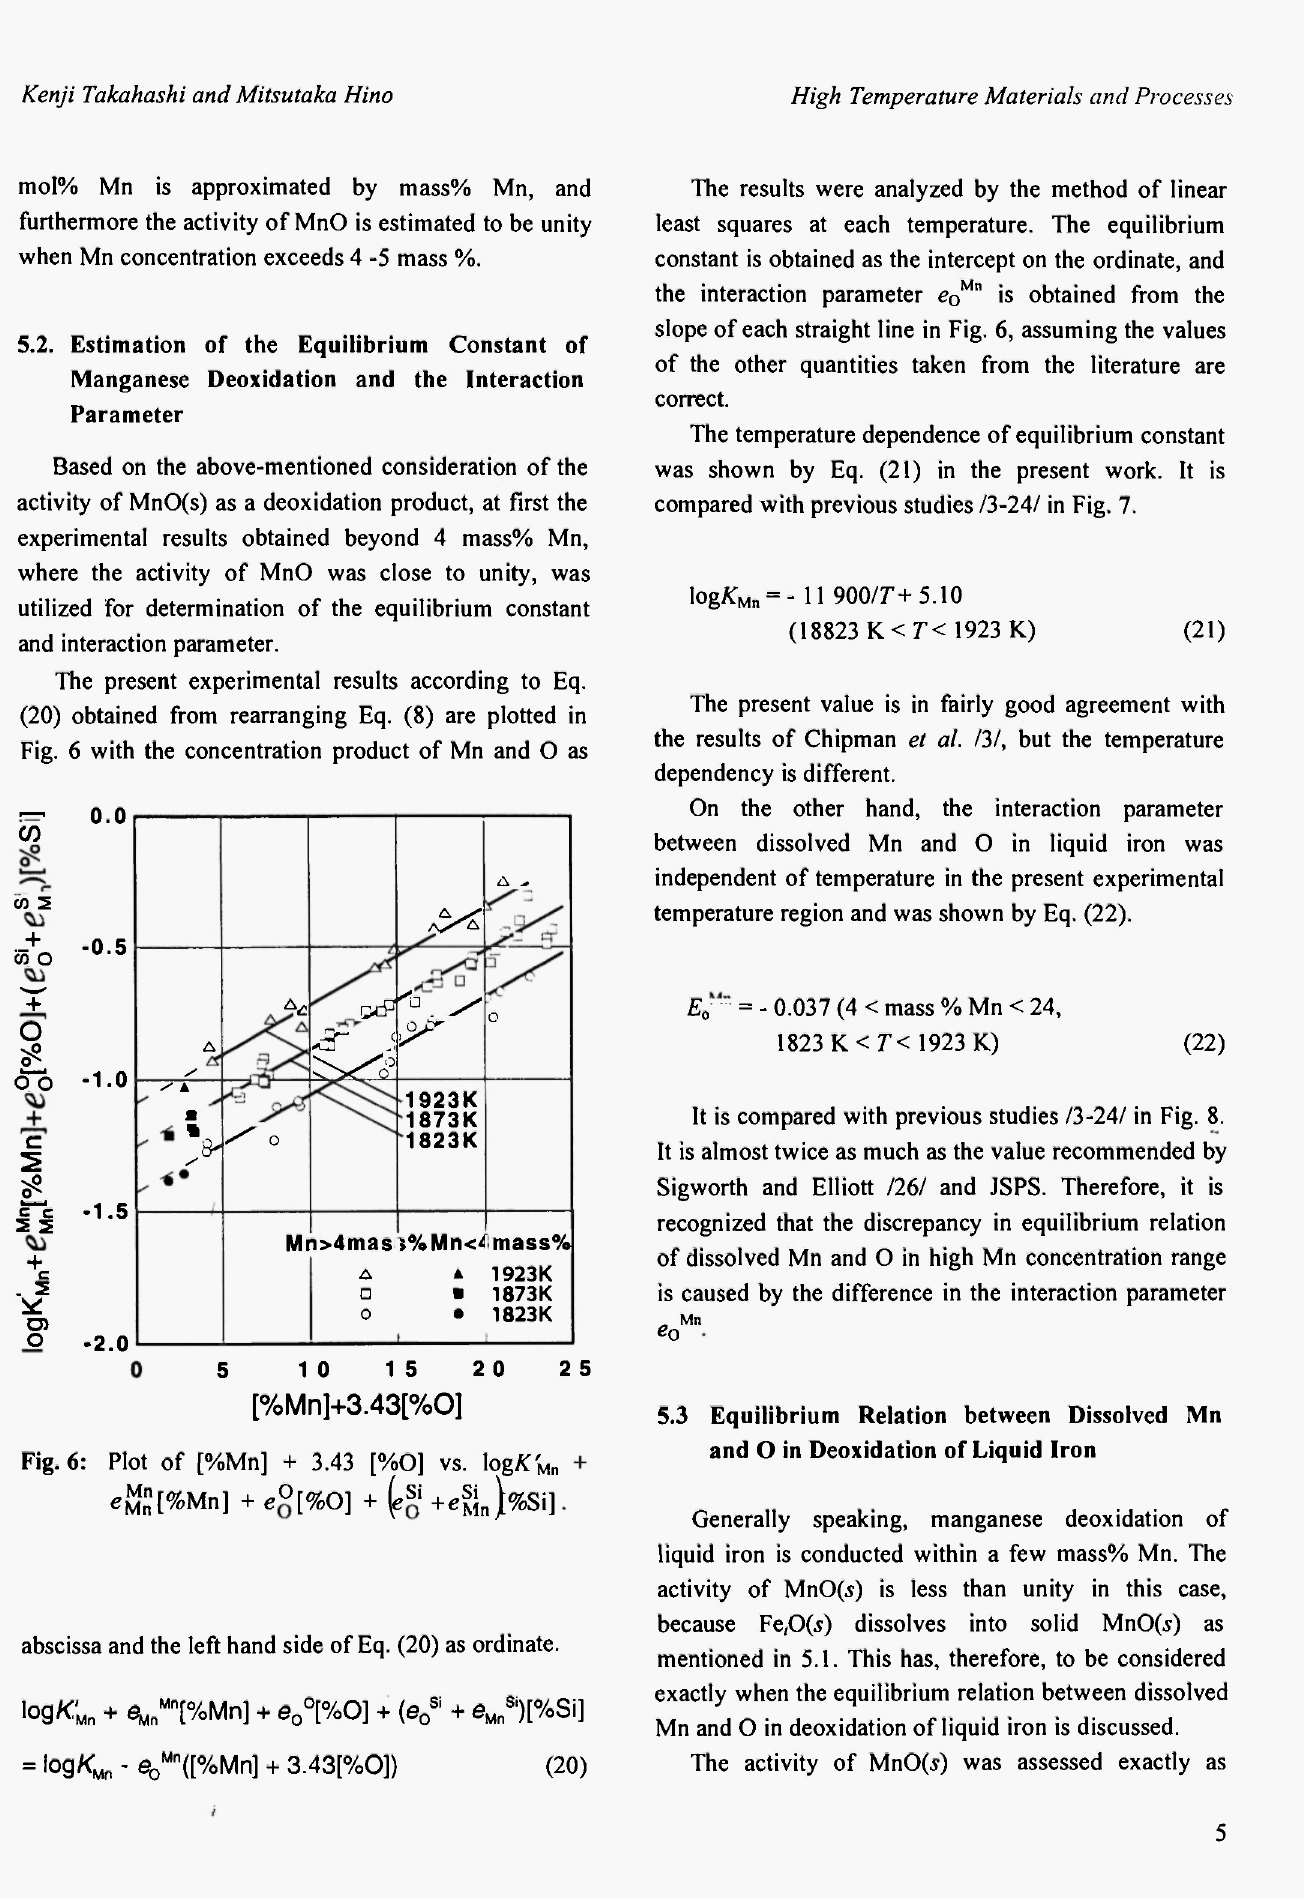
abscissa and the left hand side of Eq. (20) as